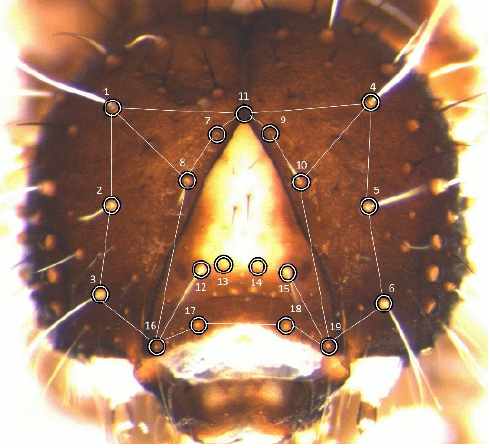
Figure 1. Position of landmarks (circles) on the head of P. brassicae larvae.